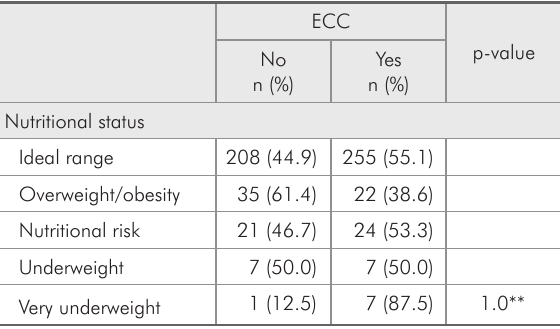
Table 2 - Distribution of ECC according to mother- and family-related